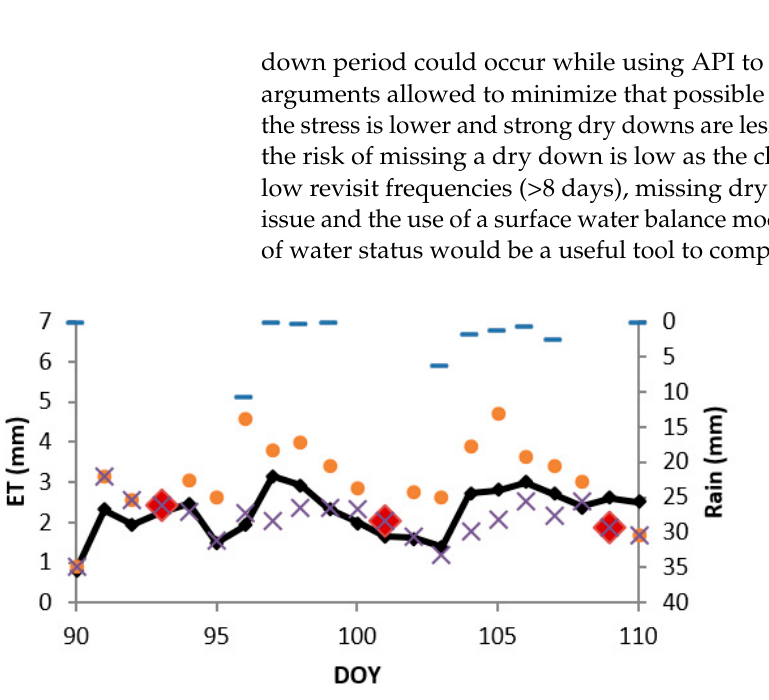
Figure 6. Reconstructed ET over a rainy period for 8 days revisit frequency in Kairouan 2012.